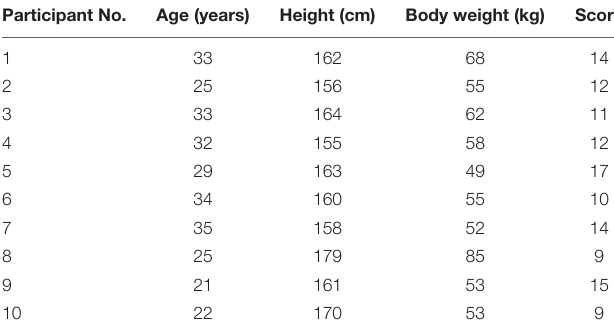
TABLE 1 | Basic information of